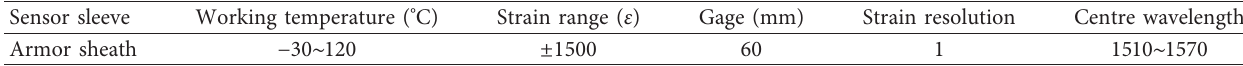
Table 2: The performance parameters of FBG sensors.